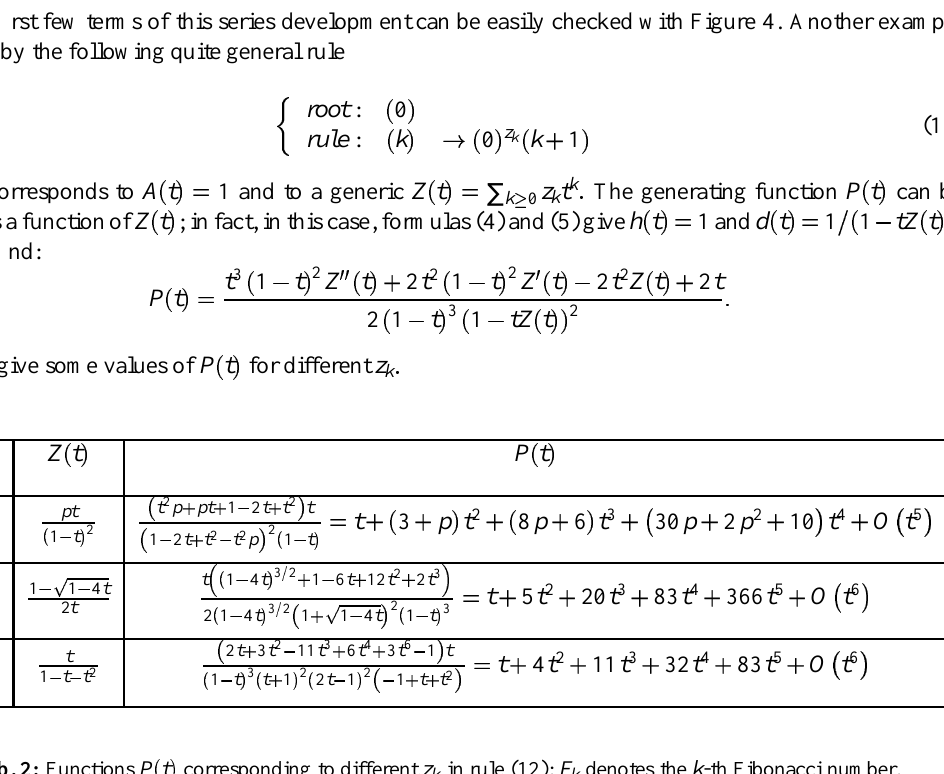
Tab. 2: Functions P (cid:1) t corresponding to different z k in rule (12); F k denotes the k -th Fibonacci number. (cid:2) Other examples concerning paths with an infinite set of jumps can be found in